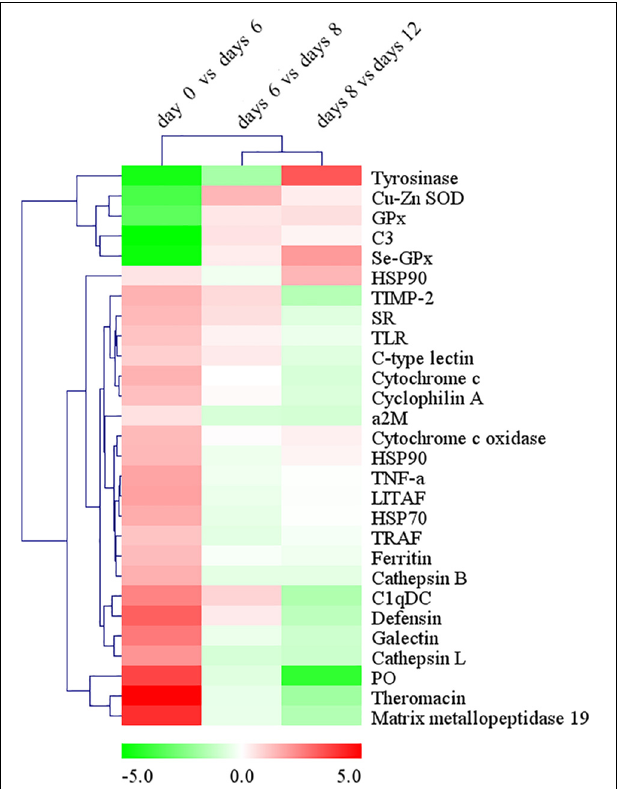
FIGURE 7 | The changes of immune-related DEGs expression during the process of pearl sac formation. Results are shown as the log 2 fold change in expression versus the mean FPKM values of immune-related DEGs (FPKM ≥ 3, log 2 fold change ≥ 2) at two adjacent time points after grafting. Hierarchical clustering analysis of DEGs’ expression changes was performed by MeV 4.8.1 to identify similarly temporal expression of genes. Up-regulated DEGs are in red, while down-regulated DEGs are in